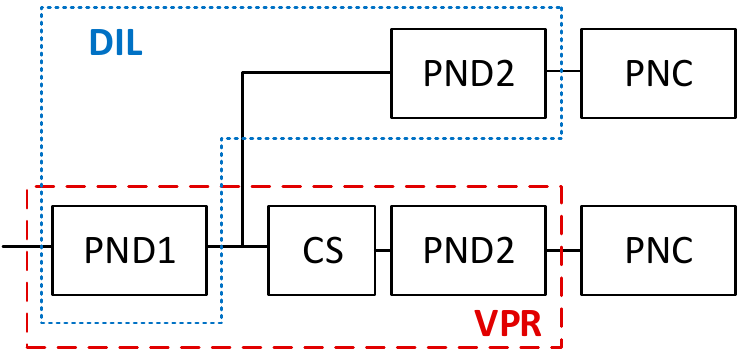
Figure 6. PN system combining total and solid particle number measurements. CS = catalytic stripper; DIL = diluter; PNC = particle number counter; PND = particle number diluter; VPR = volatile particle remover.